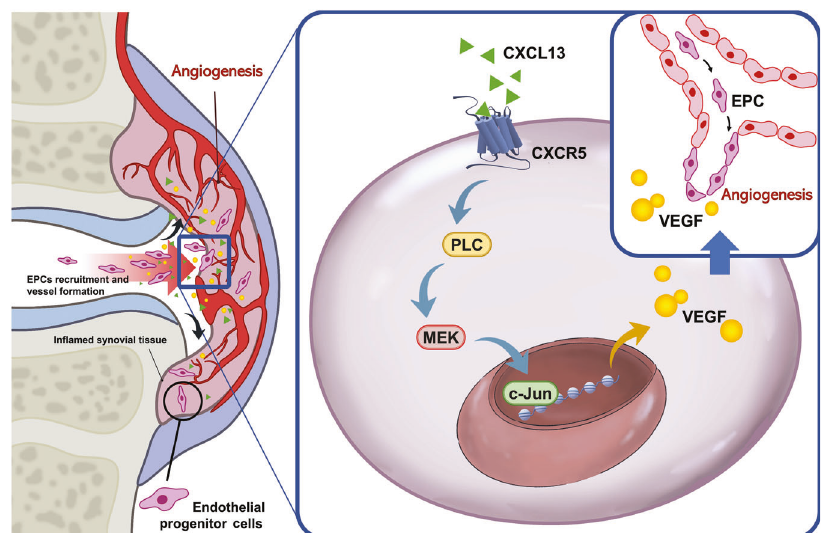
Fig. 8 Schematic diagram summarizes the mechanisms in the CXCL13/CXCR5 axis that promote EPC homing and angiogenesis during RA pathogenesis. Accumulation of CXCL13 in the synovium of RA patients promotes VEGF expression, EPC homing, and angiogenesis through the CXCR5 receptor, PLC, MEK, and AP-1 signaling